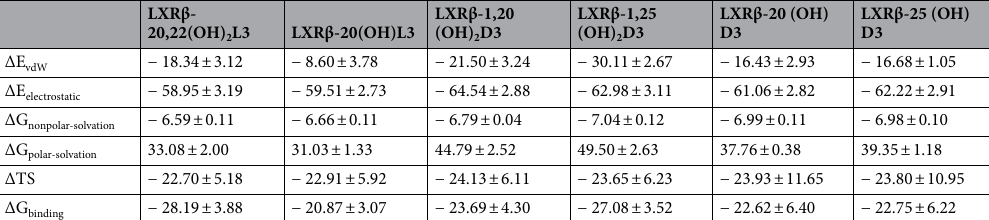
Table 4. Binding free energy between LXRβ and D3 or L3 derivatives (Kcal/mol). All values in this table were expressed in term of Kcal/mol. ΔE vdW , van der Waals energy, ΔE electrostatic , electrostatic energy; ΔG nonpolar-solvation , nonpolar solvation energy; ΔG polar-solvation , polar solvation energy; ΔTS, energy contributed from solute entropy; ΔG bingding , binding free energy for the complex.